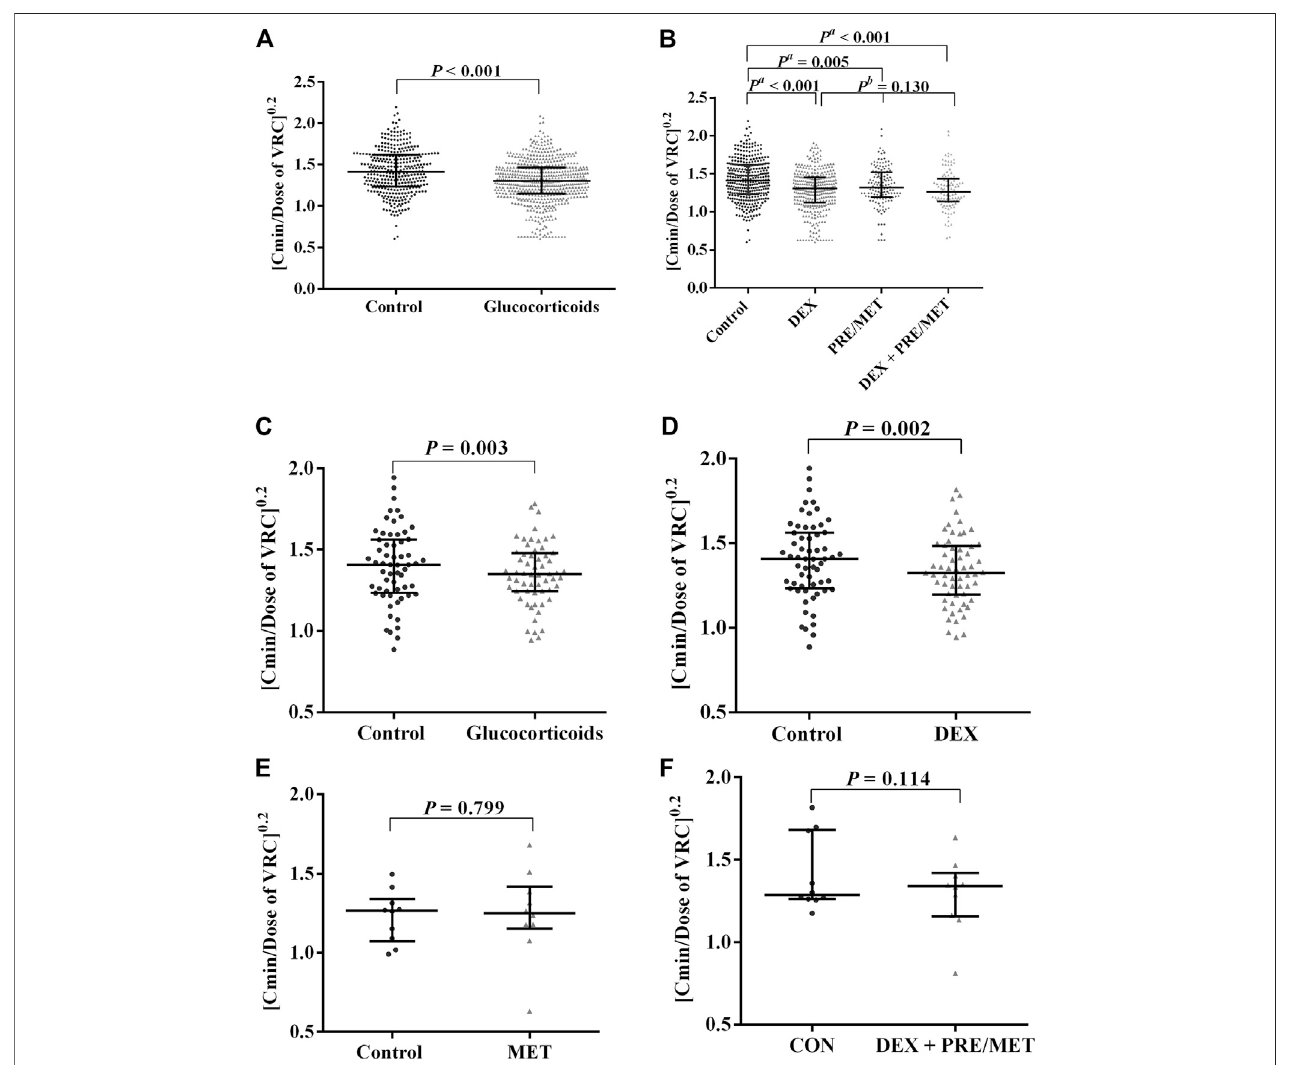
FIGURE 1 | Effects of concomitant glucocorticoids administration on the C/D ratio of VRC. The data were non-normal distribution and expressed as median with interquartilerange.Theordinate(C/DratioofVRC)wasprocessedtothepowerof0.2.DEXwasabbreviationofdexamethasone,PREwasabbreviationofprednisoneor prednisolone,and METwasabbreviation ofmethylprednisolone. Nrepresentedthenumberofpatientsenrolledandnrepresentedthenumber ofVRCconcentrationsin the group. (A) showed that the C/D ratio of VRC was signi fi cantly higher in the control patients ( n (cid:2) 348) than the patients receiving glucocorticoids therapy simultaneously( n (cid:2) 570)( p < 0.001). (B) showedtheC/DratioofVRCinthepatientsaccompanyingdifferentkindsofglucocorticoidscomparedwiththecontrolpatients ( n (cid:2) 348).CoadministrationwithDEX( n (cid:2) 334, p < 0.001),PRE/MET( n (cid:2) 134, p (cid:2) 0.005),andDEX+PRE/MET( n (cid:2) 102, p < 0.001)couldallreducetheC/DratioofVRC signi fi cantly, but there was no statistical difference among these three groups ( p b (cid:2) 0.130) ( Supplemental Table S1 ). (C) showed that the C/D ratio of VRC was signi fi cantly higher in the control patients ( n (cid:2) 197) than the patients receiving glucocorticoids therapy simultaneously ( n (cid:2) 310) (N (cid:2) 60, p (cid:2) 0.003). (D) showed that the C/DratioofVRCinthepatientstakingDEX( n (cid:2) 236)wassigni fi cantlylowerthanthecontrolpatients( n (cid:2) 197)(N (cid:2) 60, p (cid:2) 0.002). (E) showedthattheC/DratioofVRCin the patients taking MET ( n (cid:2) 31) had no statistical difference compared with the control patients ( n (cid:2) 51) (N (cid:2) 10, p (cid:2) 0.799). (F) showed that the C/D ratio of VRC in the patients taking DEX + PRE/MET ( n (cid:2) 35) had no statistical difference compared with the control patients ( n (cid:2) 37) (N (cid:2) 10, p (cid:2) 0.114) ( Supplemental Table S2 ).